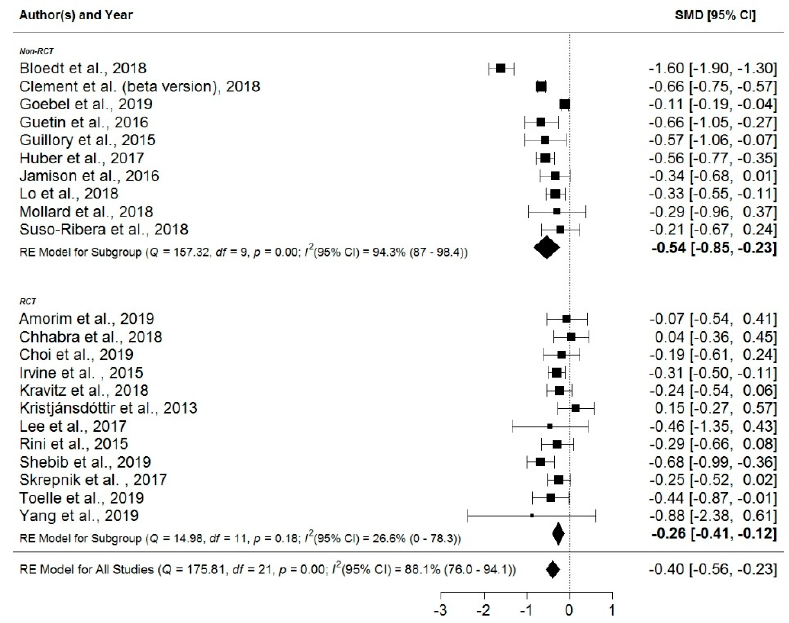
Figure 6. Forest plot. Abbreviations: CI = confidence interval; df = degrees of freedom; RCT = randomized- controlled trial; RE = random effect; SMD = standardized mean difference.